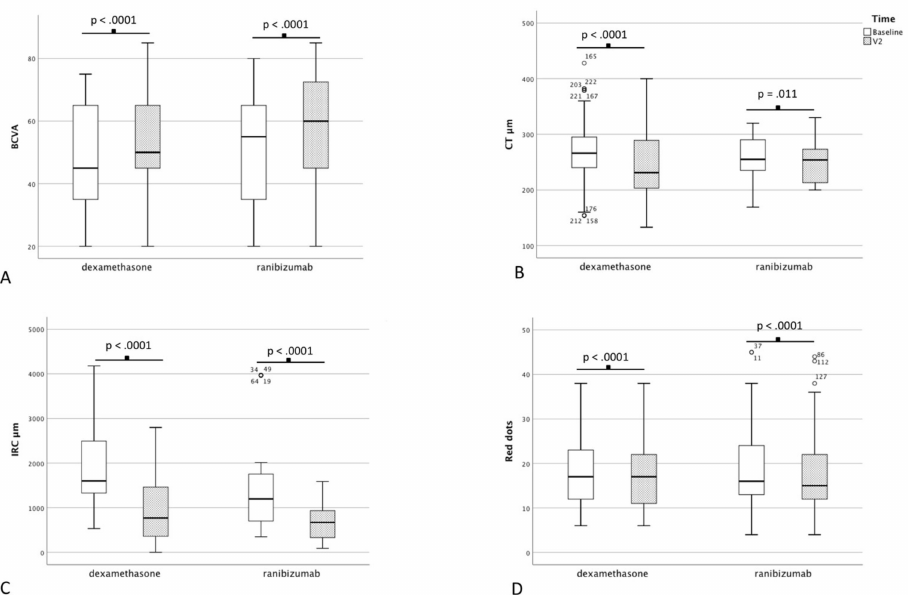
Figure 2. Box plot of: ( A ) best-corrected visual acuity, ( B ) choroidal thickness, ( C ) intra-retinal cysts, and ( D ) red dots.